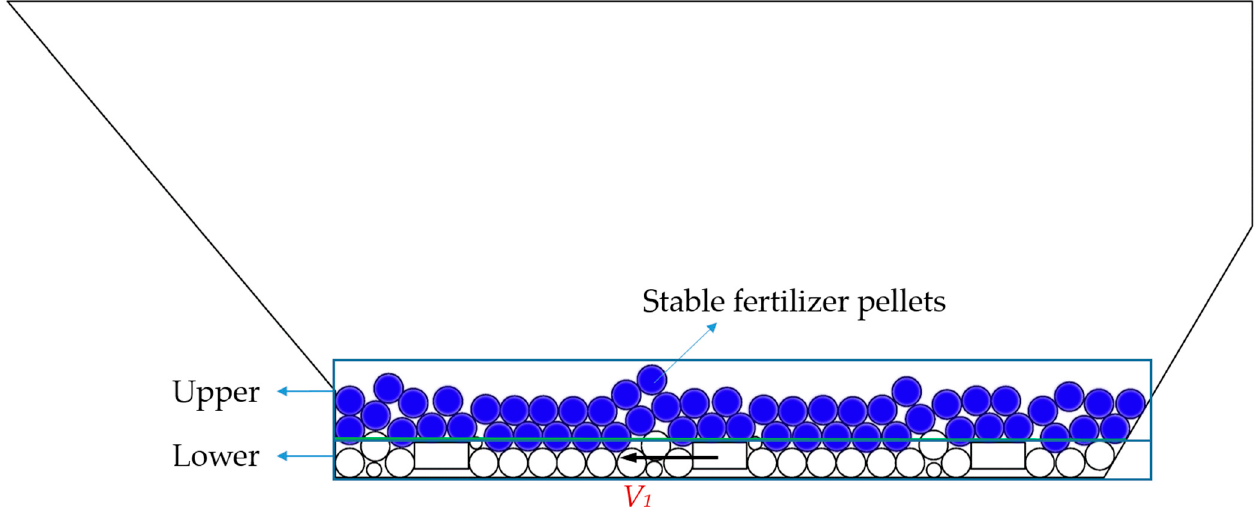
Figure 3. Schematic diagram of scraper movement.